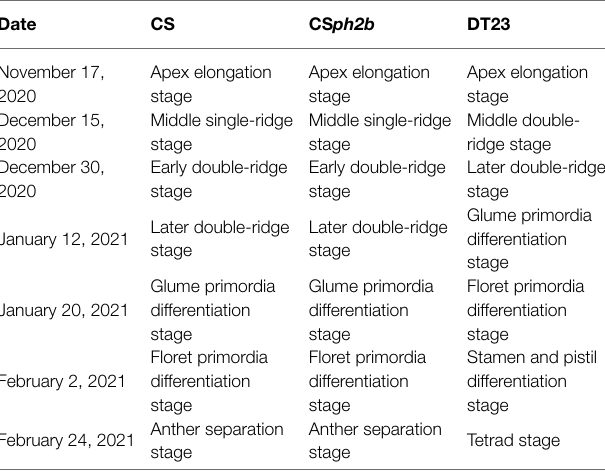
TABLE 3 | Spike differentiation of CS, CS ph2b , and DT23 at different